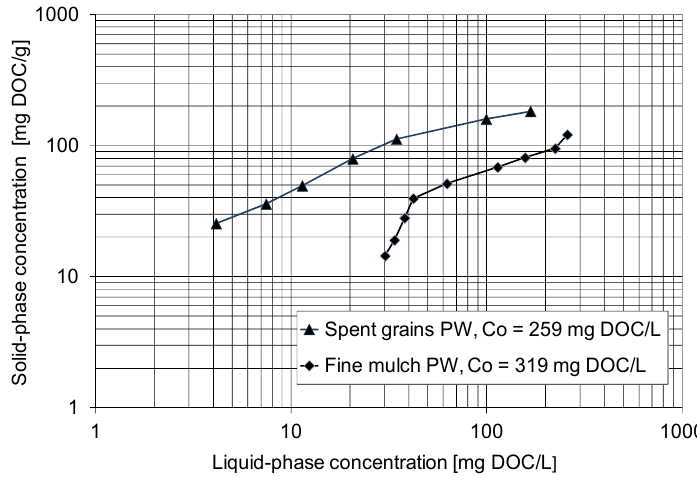
Figure 1. Comparison of overall isotherms of pre-treated HTC spent grains and fine mulch process water (PW).